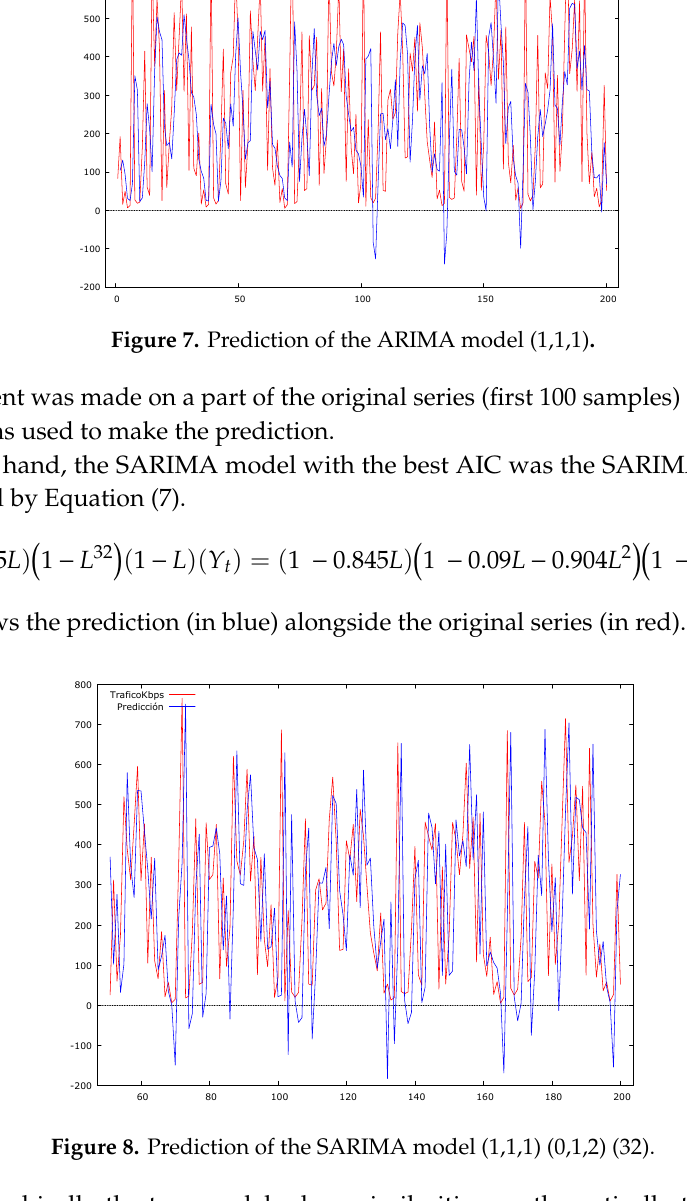
Table 4. RMSE (Root-Mean-Square Error) value for various models.